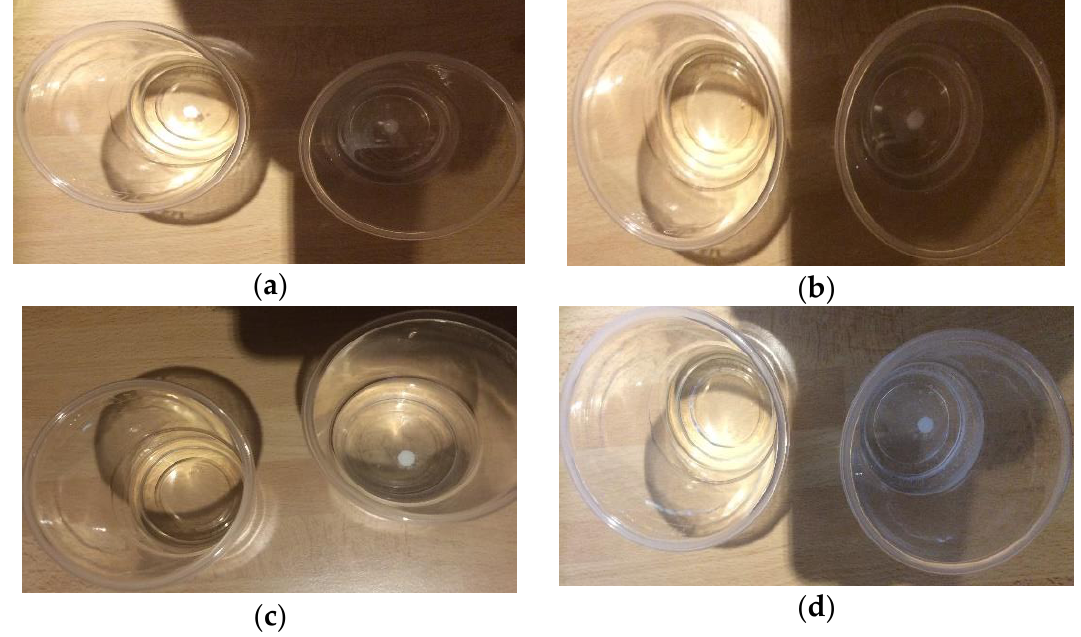
Figure A1. Drop test showing emulsions of droplets deposited on pure sunflower oil on the left and on water on the right: ( a ) at the start of the test; ( b ) after 8 min, when the emulsion droplet was completely dispersed while the one in water did not disperse; ( c ) after 40 min, when the emulsion droplet was completely dispersed while the one in water did not disperse; and ( d ) after 1 h, when the emulsion droplet was completely dispersed while the one in water did not disperse.